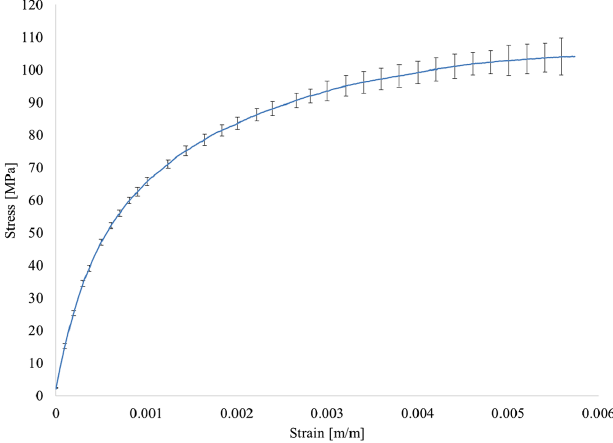
FIG. 15. Plot of flexural stress against strain for CuCD.